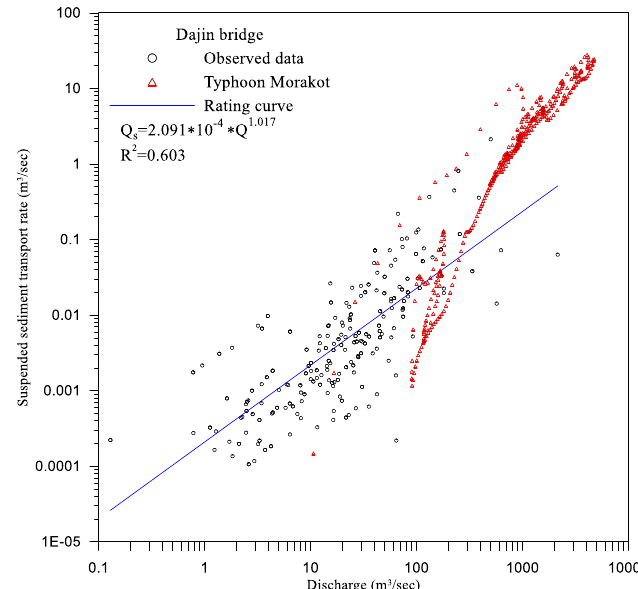
Figure 13. Simulated and observed correlation between flow discharge and sediment transport rate at Dajin Bridge station.